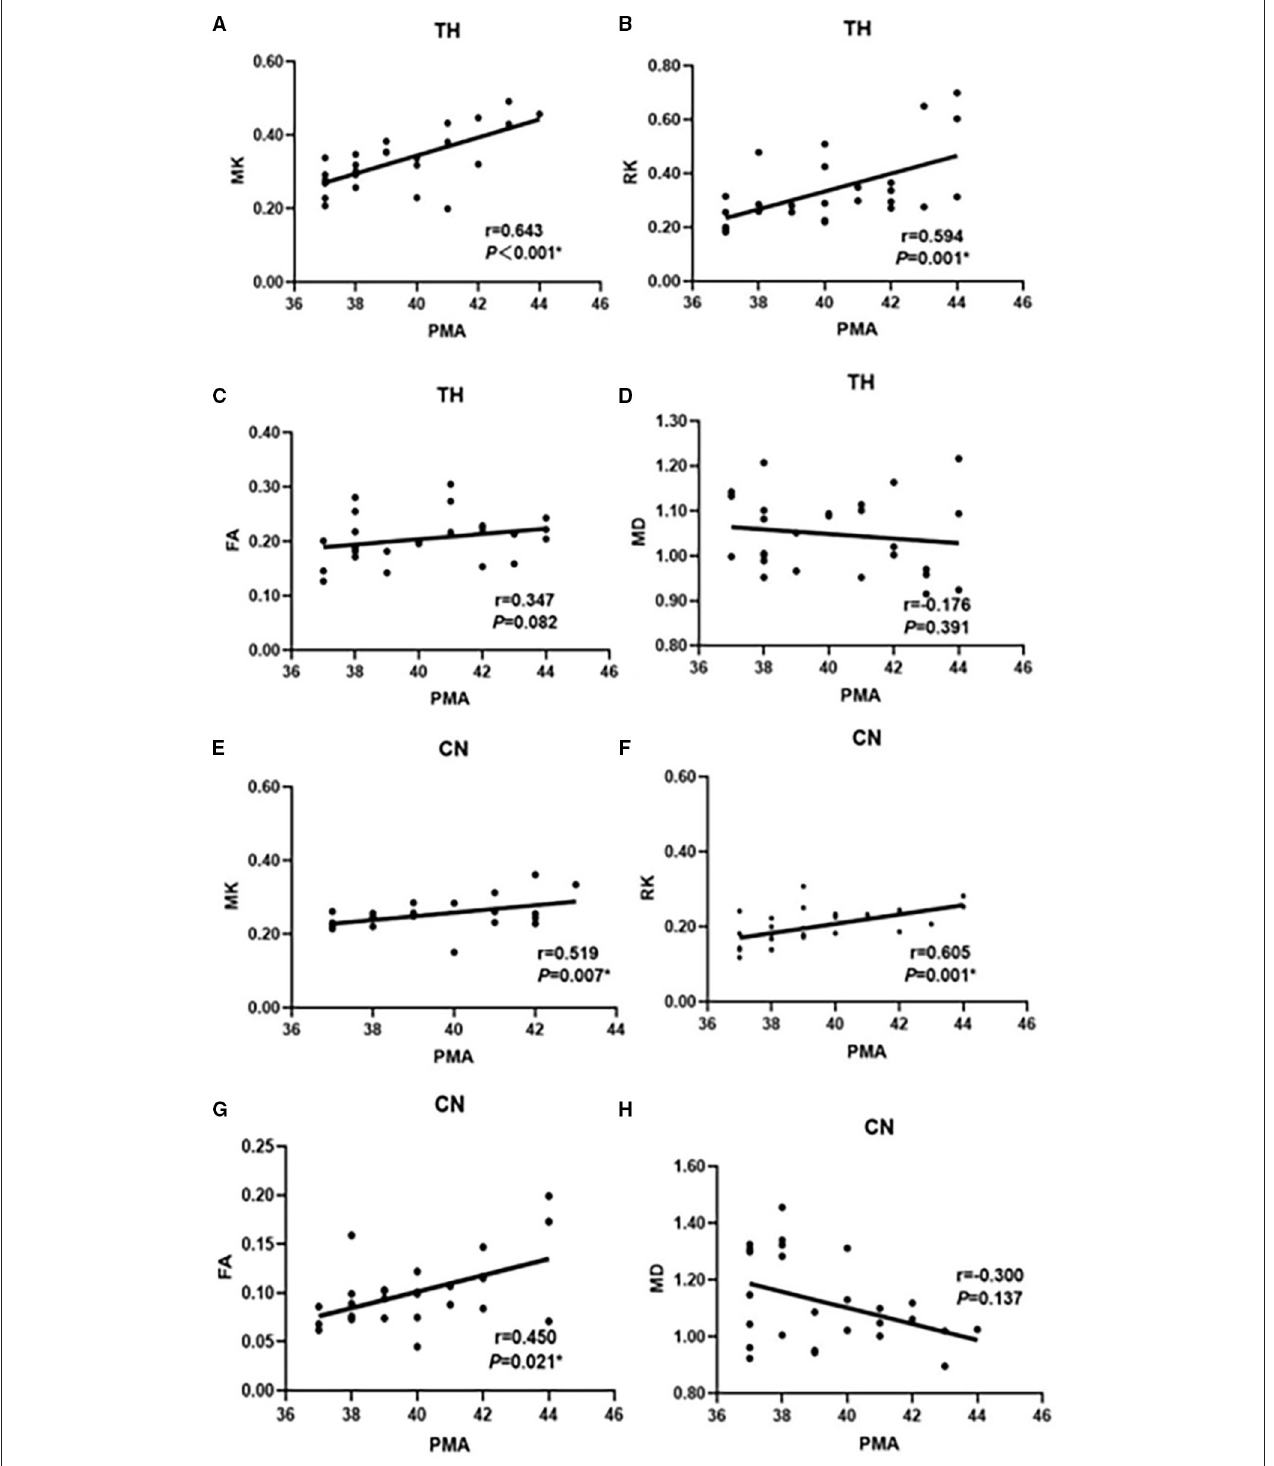
FIGURE 3 | Correlation between MK, RK, FA, MD, and PMA in TH (A–D) ; Correlation between MK, RK, FA, MD, and PMA in CN (E–H) in the preterm infants ( n = 26). MK and FA regression lines with correlational coefficient ( r ). correlation significance ( P ). The selected ROI are the thalamus and the caudate nucleus. PMA, postmenstrual age; TH, thalamus; CN, caudate nucleus; MK, mean kurtosis; RK, radial kurtosis; FA, fractional anisotropy; MD, mean diffusivity.